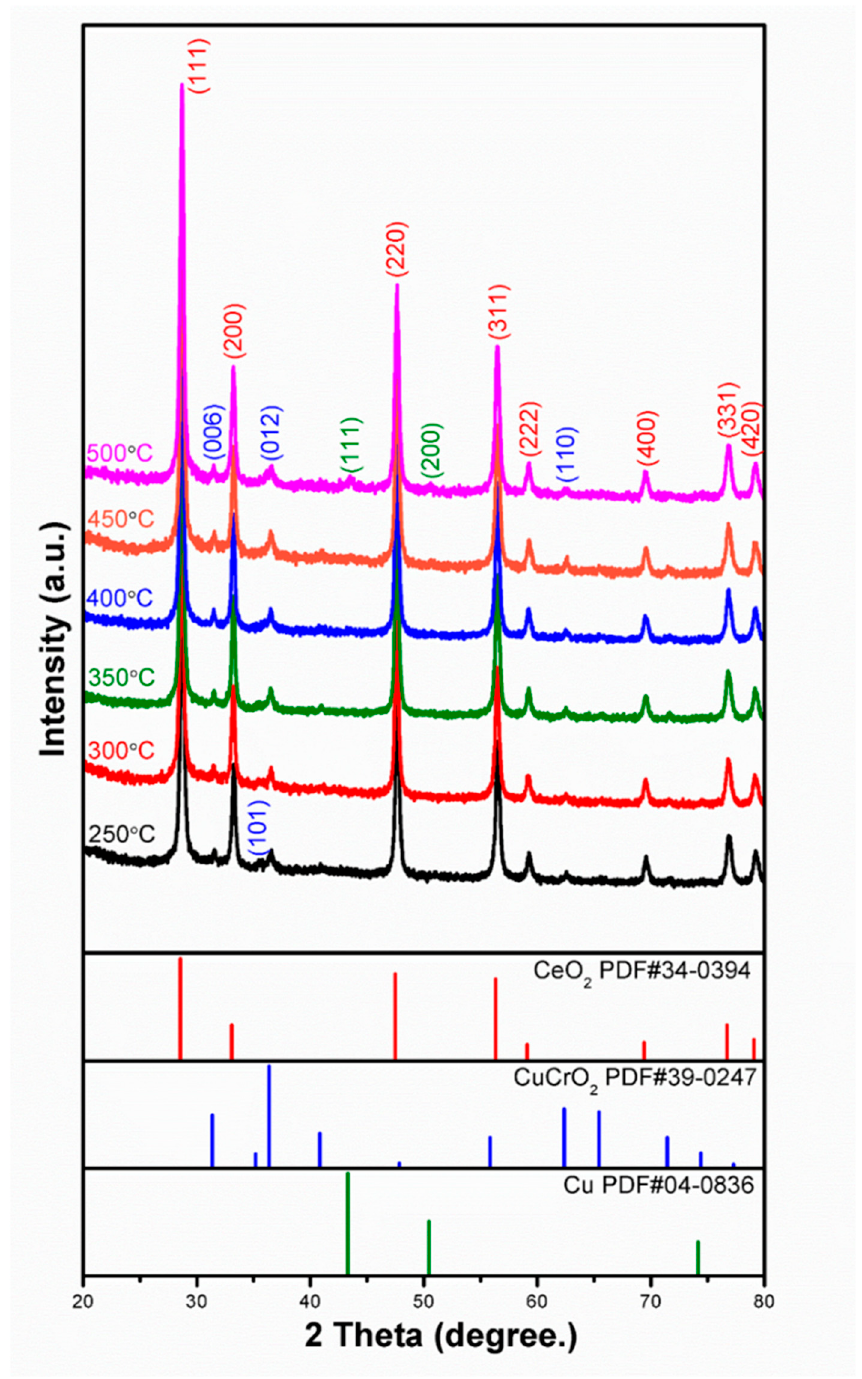
Figure 3. XRD pattern of CeO 2 -CuCrO 2 nanofibers after SRM at different